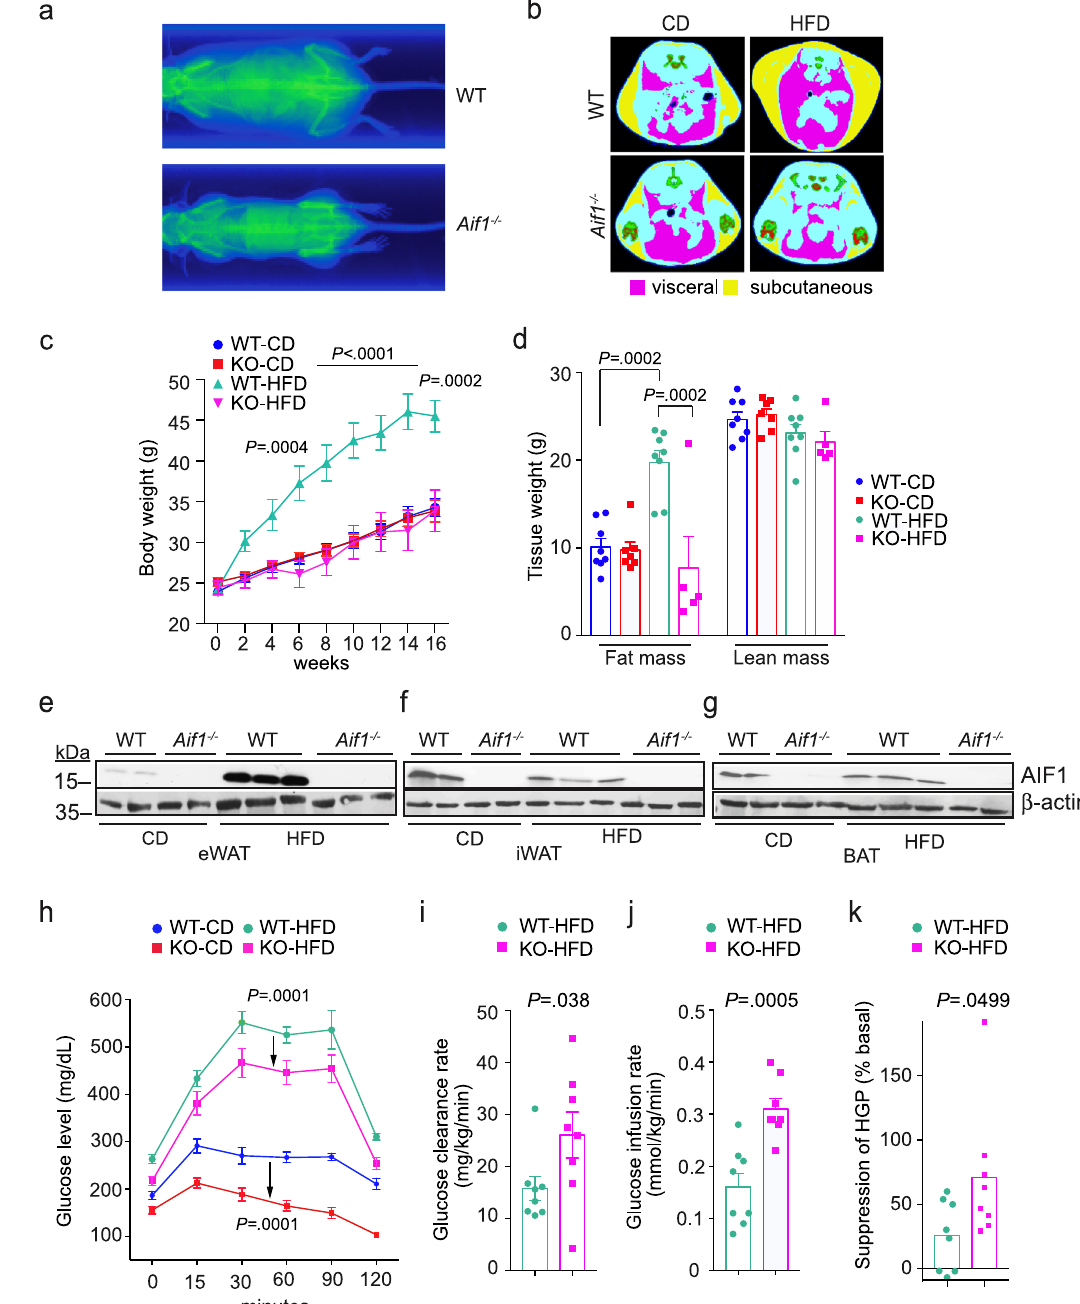
Fig.1|LossofAIF1preventsobesityandinsulinresistanceinducedbyHFD. WT and Aif1 − / − (KO) mice were assigned to chow (CD) or high-fat diet (HFD) starting at 8 weeks of age. a , b Computerized tomographic scans were performed after 16 weeks on diet. a Whole body projections show skeletal and soft tissue signals. b False-colored cross-sectional samples indicate visceral (pink) and subcutaneous (yellow)adiposetissues,pluslean(lightblue)andskeletal(green)elements. c Body weight measured at the indicated time points after starting on CD or HFD ( n : WT- CD, 9; KO-CD, 6; WT-HFD, 9; KO-HFD, 9). d Fat and lean masses measured by magnetic resonance imaging after 16 weeks on diet ( n : WT-CD, 8; KO-CD, 7; WT- HFD,8;KO-HFD,5). e – g AIF1expressionafter16weeksondietassessedbyWestern